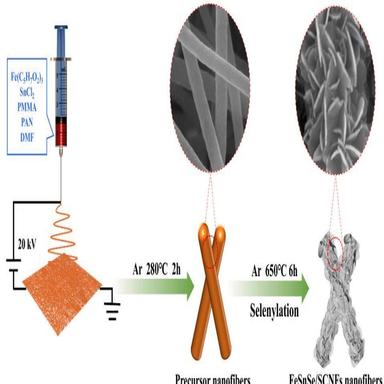
An illustration of the preparation procedure for FeSnSe/SCNFs composites.